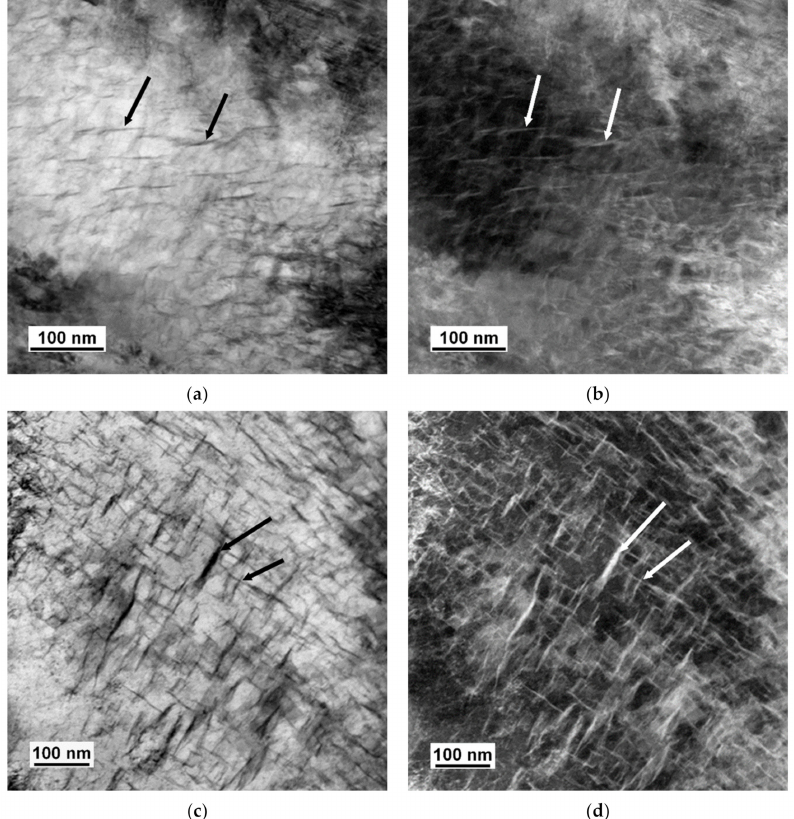
Figure 5. Iron transition carbides in lath martensite tempered at 200 ◦ C for 2 h in 42SiCr